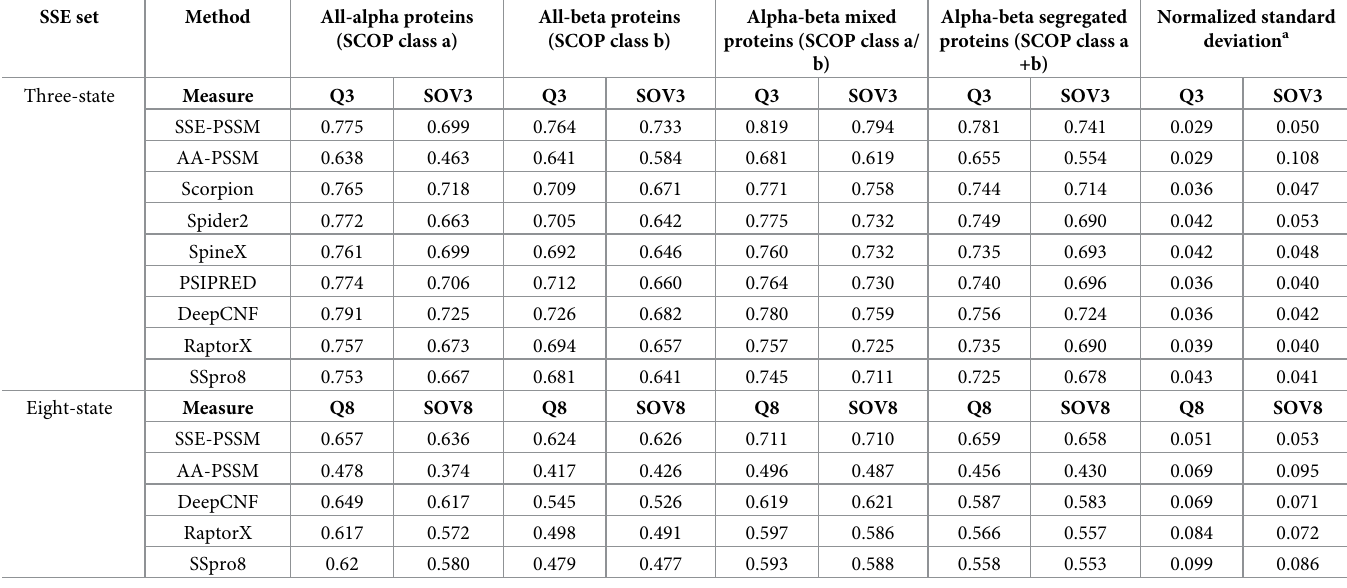
Table 2. Accuracy of several SSP methods for proteins of different structural classes. SSE